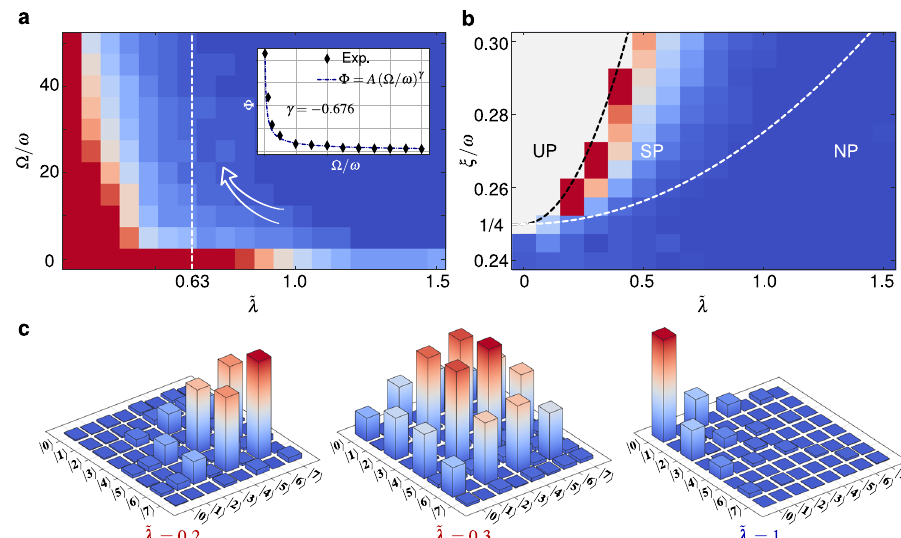
Fig. 4 Modulated ground-state phase diagram by the antisqueezing. a The measured order parameter Φ versus ~ λ and Ω / ω for ξ / ω = 0.26. The inset plot shows the experimental power-law scaling of Φ at the critical point, and the fi tted fi nite-frequency scaling exponent is γ = − 0.676. The white dashed line corresponds to the exact critical point in the limit Ω / ω → ∞ . b The dependence of Φ on ~ λ and ξ / ω for Ω / ω = 20. The white (black) dashed line corresponds to the critical parameter distinguishing NP and SP (SP and UP). c , The reduced density matrix ^ ρ s a ¼ tr σ ð G j i s G h jÞ for Ω / ω = 25, obtained by the experimentally reconstructed ground state of ^ H s . The diagonal elements contribute to (cid:3) ^ a 2 s . Other parameters are the same as that in Fig.